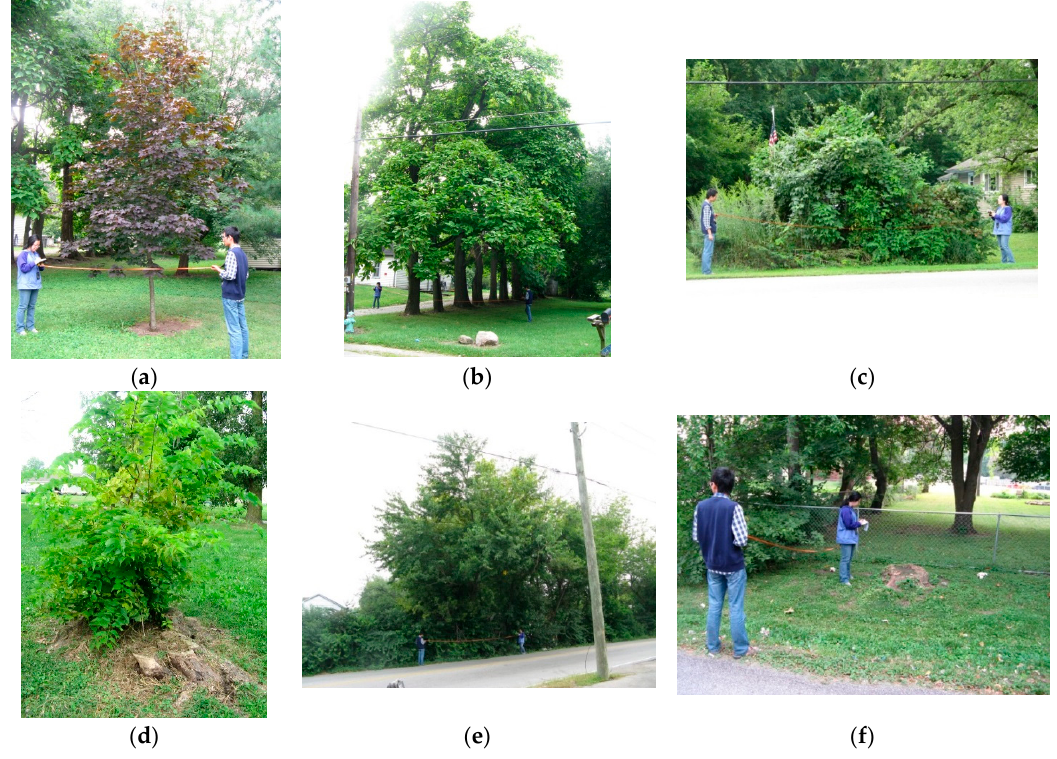
Figure 7. Stand-alone trees ( a ) and stands with similar species ( b ) segment easily; trees with vine and shrub ( c , d ) are hard to be segmented; Trees may have changed form from previous data collecting because of removal ( e ) and growing after removal ( f ).